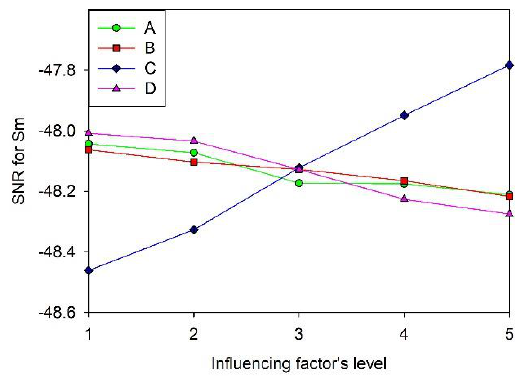
Figure 16. Effect diagram of SNR at different levels for Sm.